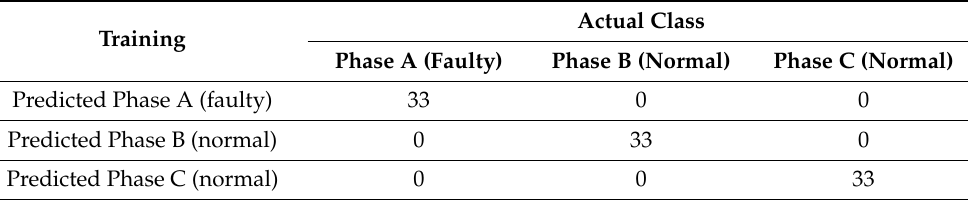
Table 5. Confusion matrix for faulty phase detection using SK and SVM in case study